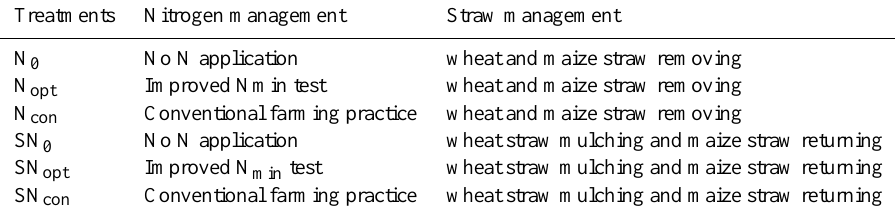
Table 1. Treatments of the long-term field experiment. Treatments Nitrogen management Straw management N 0 No N application wheat and maize straw removing N opt Improved Nmin test wheat and maize straw removing N con Conventional farming practice wheat and maize straw removing SN 0 No N application wheat straw mulching and maize straw returning SN opt Improved N min test wheat straw mulching and maize straw returning SN con Conventional farming practice wheat straw mulching and maize straw